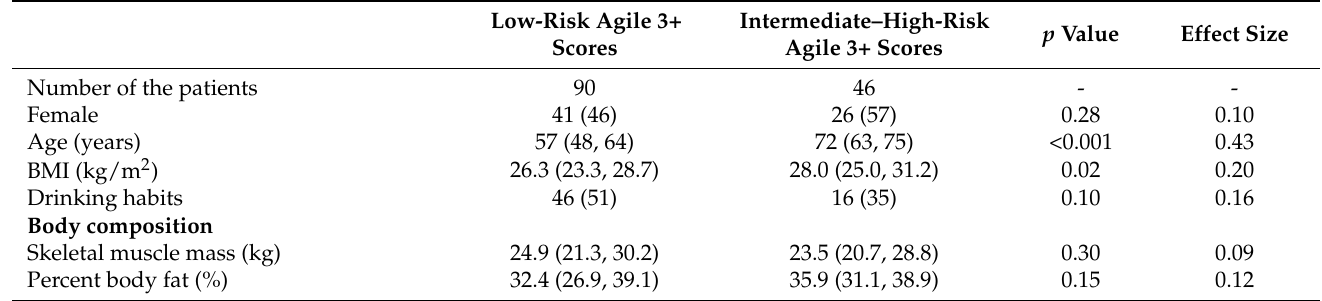
Table 2. Subject characteristics and laboratory data related to liver status, grouped by the Agile 3+ score